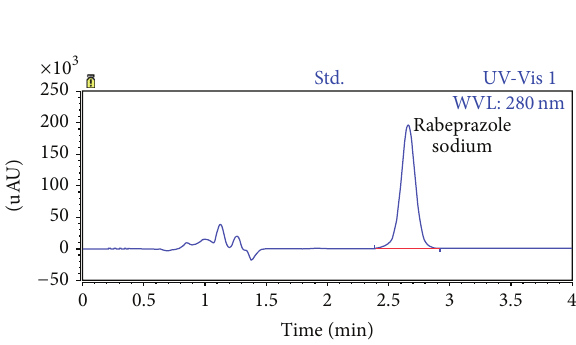
Figure 4: Chromatogram of rabeprazole sodium from Dionex HPLC 3000 Series.